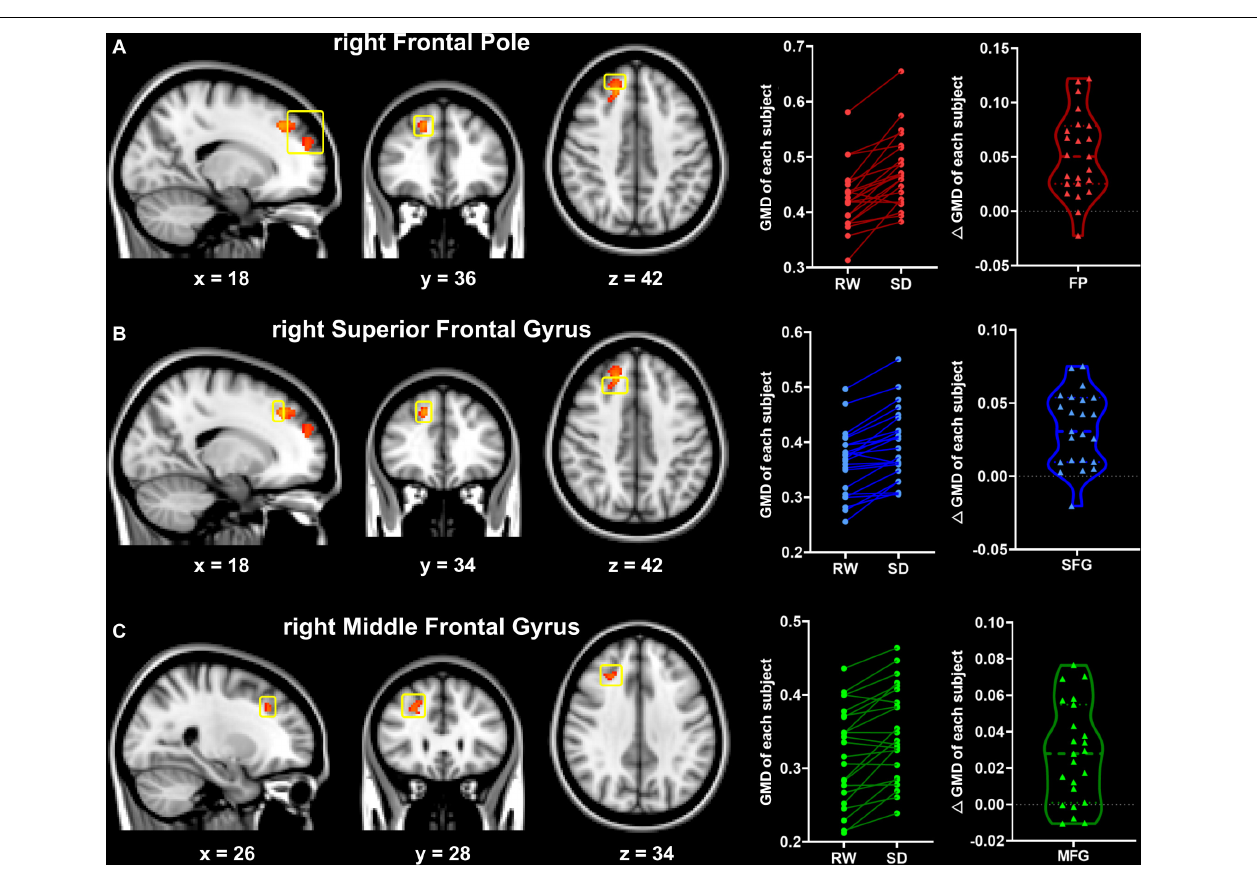
FIGURE 2 | Significant changes in gray matter density between the RW and SD states (RW < SD, TFCE-corrected, p < 0.05). Significant brain regions included the right frontal pole (FP, A ), the right superior frontal gyrus (SFG, B ), and the right middle frontal gyrus (MFG, C ). The yellow box indicates the significant brain regions. The numbers at the bottom indicate the MNI coordinates of the slices. RW, rested wakefulness; SD, sleep deprivation.